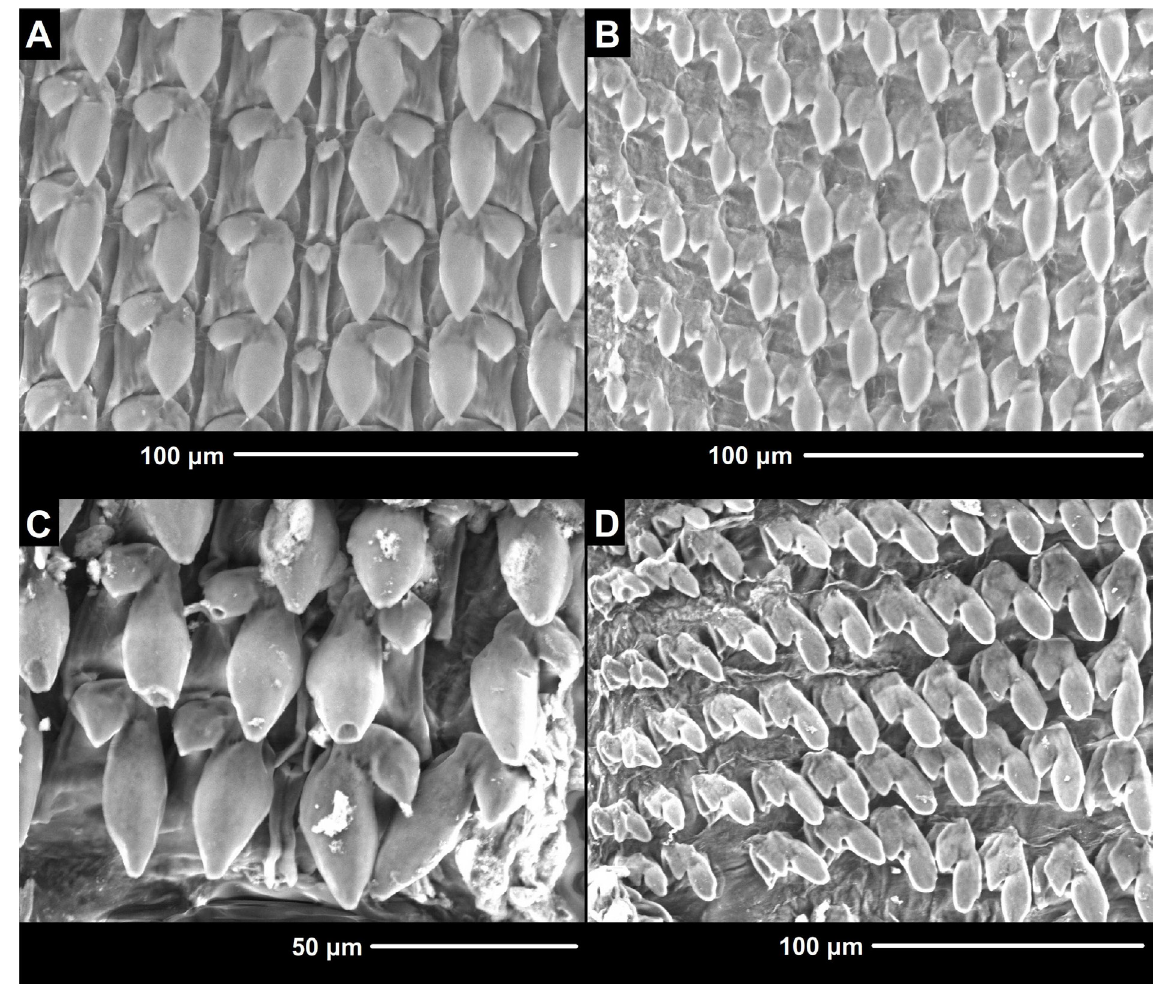
Fig. 46. Radula of Plectopylis Benson, 1860 species. A, C . Central and first lateral teeth. B, D . Marginal teeth. A–B . Plectopylis malayana sp. nov. (loc. 2013/14, coll. HA). C–D . Plectopylis thompsoni sp. nov. (UF 76482). All images: B.